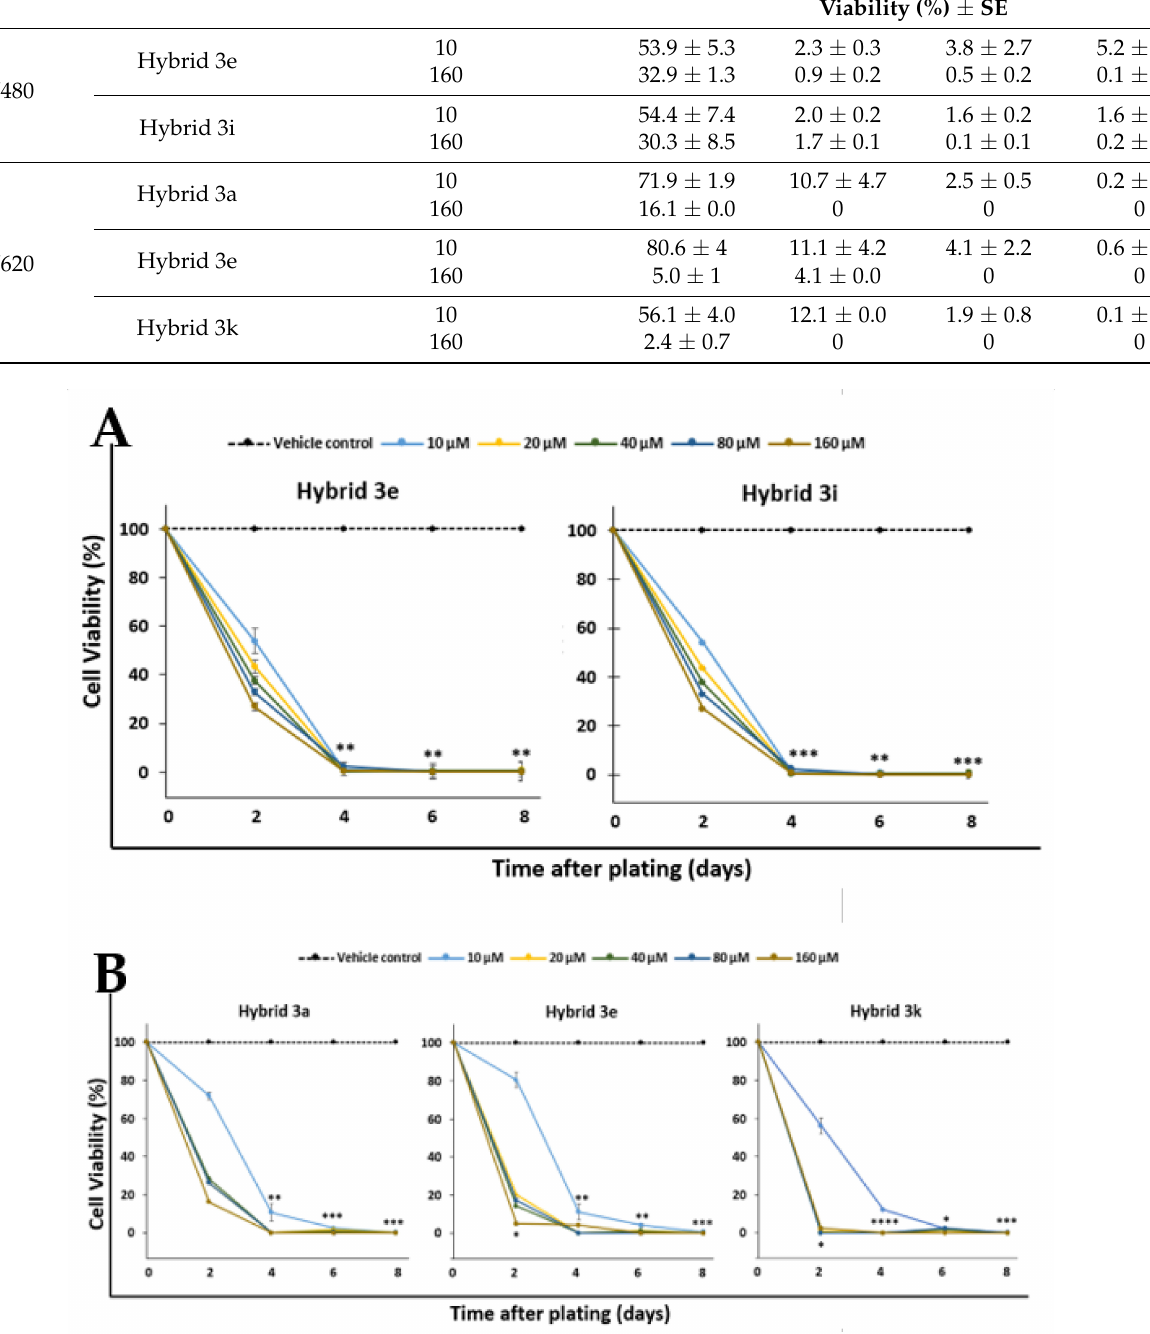
Figure 3. Antiproliferative effect of hybrids based on curcumin and resveratrol against: SW480 cell line ( A ); and its metastatic derivative SW620 cell line ( B ). Data are presented as the mean ± SE of at least three independent experiments (* p < 0.05; ** p < 0.01; *** p < 0.001; **** p < 0.0001). Vehicle control was assumed as 100% of